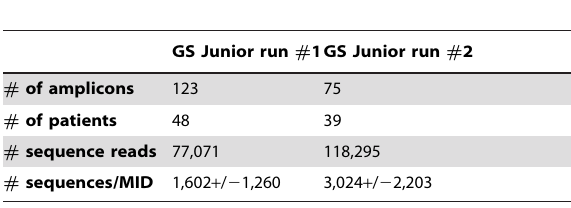
Table 2. The statistics of the two GS Junior runs used to assess the patient samples in this